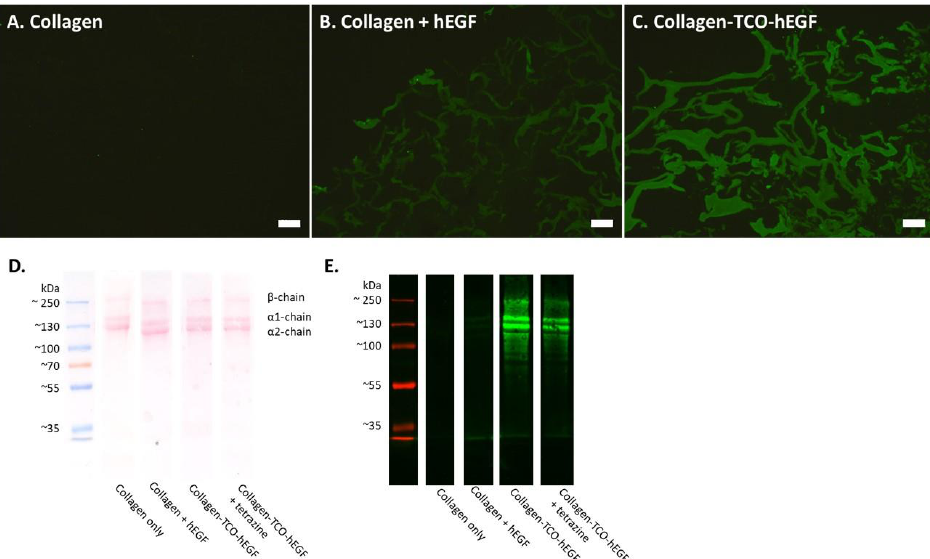
Figure 3. Successful immobilization of hEGF–TCO to collagen scaffolds. Immunofluorescent de- tection of hEGF on collagen scaffold cryo-sections ( A – C ) and Western blotting ( D , E ). ( A ) Nega- tive control of collagen scaffold without hEGF, ( B ) collagen scaffold incubated with hEGF only, and ( C ) collagen scaffold conjugated with hEGF–TCO. Scale bar = 50 µ m. Green color indicates hEGF. All images were acquired under identical exposure time and laser intensity. ( D ) Total protein load of Western blot of collagen scaffolds is visualized by Ponceau S. ( E ) Western blot of collagen scaffolds, where hEGF is indicated by the green signal. Pre-stained marker stains red under these